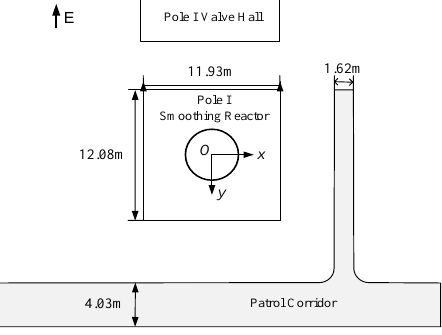
Figure 2. Layout diagram of smoothing reactors.